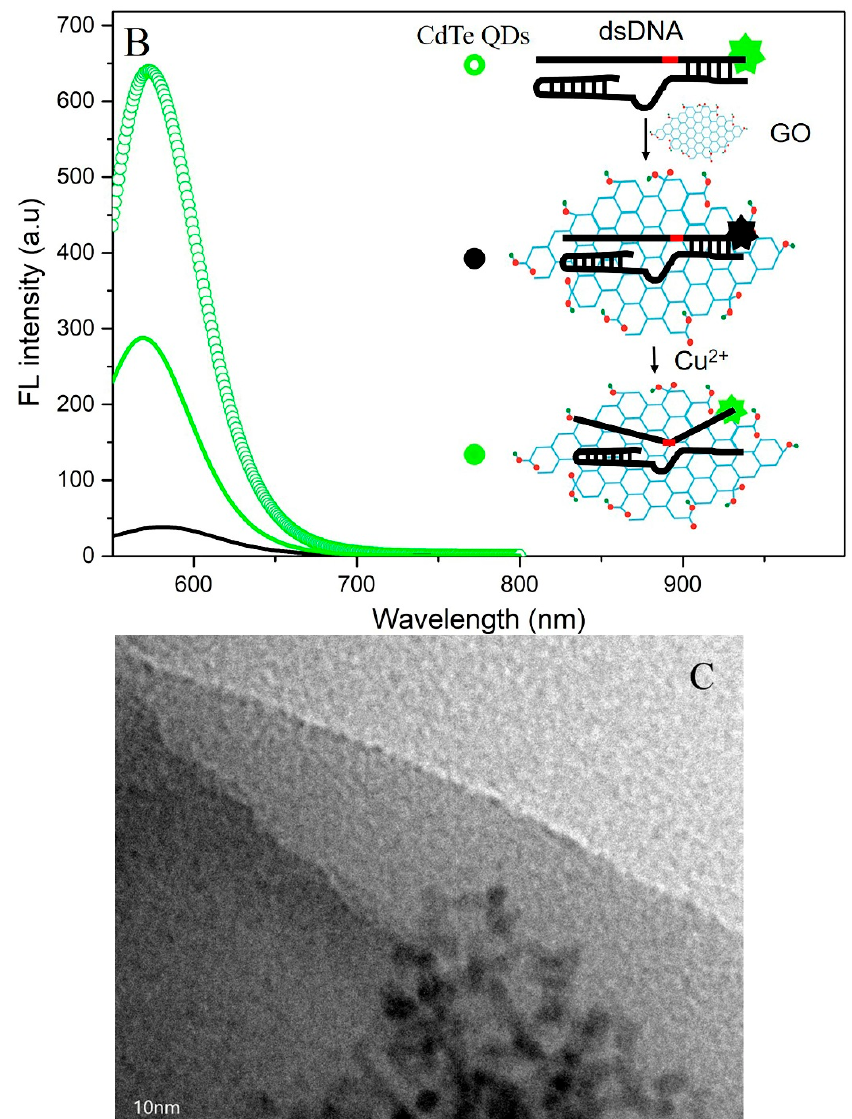
Figure 1. ( A ) Illustration of the operating principle of the “turn-on” fluorescent sensor for Cu 2+ detection; ( B ) The FL spectra of GO-dsDNA-CdTe QDs complex in the absence or presence of Cu 2+ ; ( C ) TEM images of GO-CdTe nanocomposite.